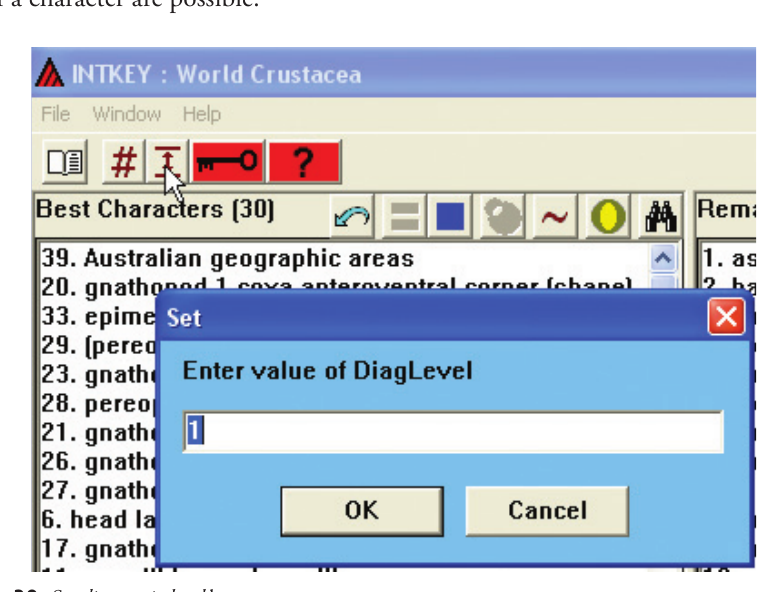
Figure 39. Set diagnostic level button.